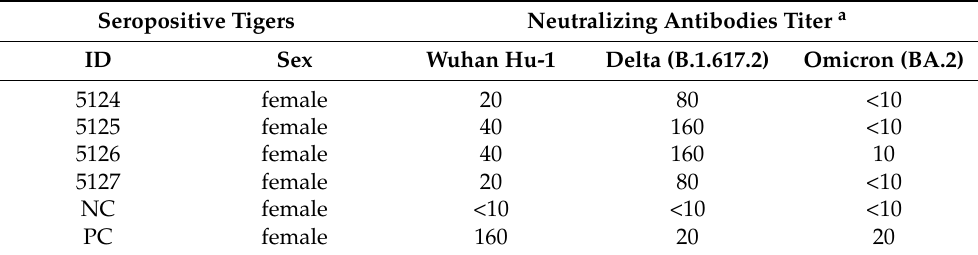
Table 2. Neutralizing antibody titers against strains of SARS-CoV-2 in seropositive tigers.